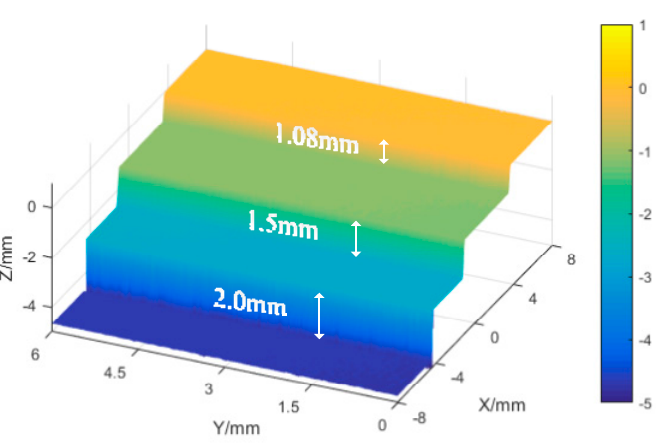
Figure 8. Point cloud measurement results of the gauge block ladder.